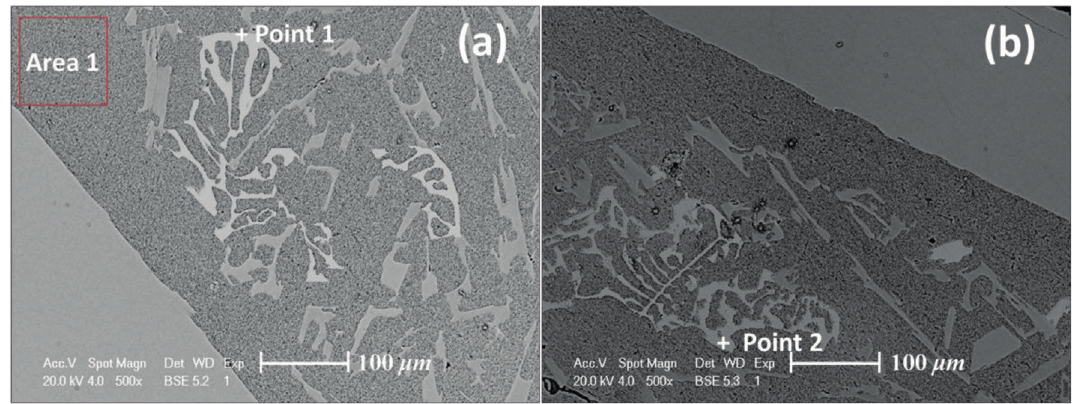
Fig. 6: SEM image of solidified 40% mass Si-Al alloy cooled at 0.81